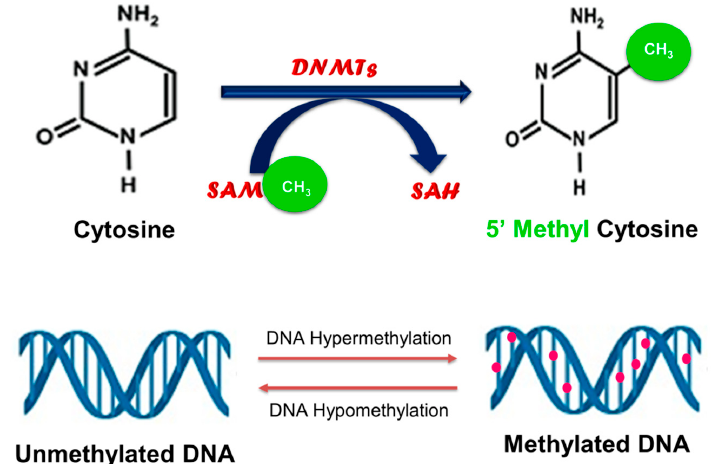
Figure 1. Process of DNA methylation. DNA methyltransferases (DNMT1, DNMT3A, and DNMT3B) catalyze the transfer of a methyl group from the universal methyl donor S-adenosylmethionine (SAM), resulting in the formation of 5-methylcytosine.